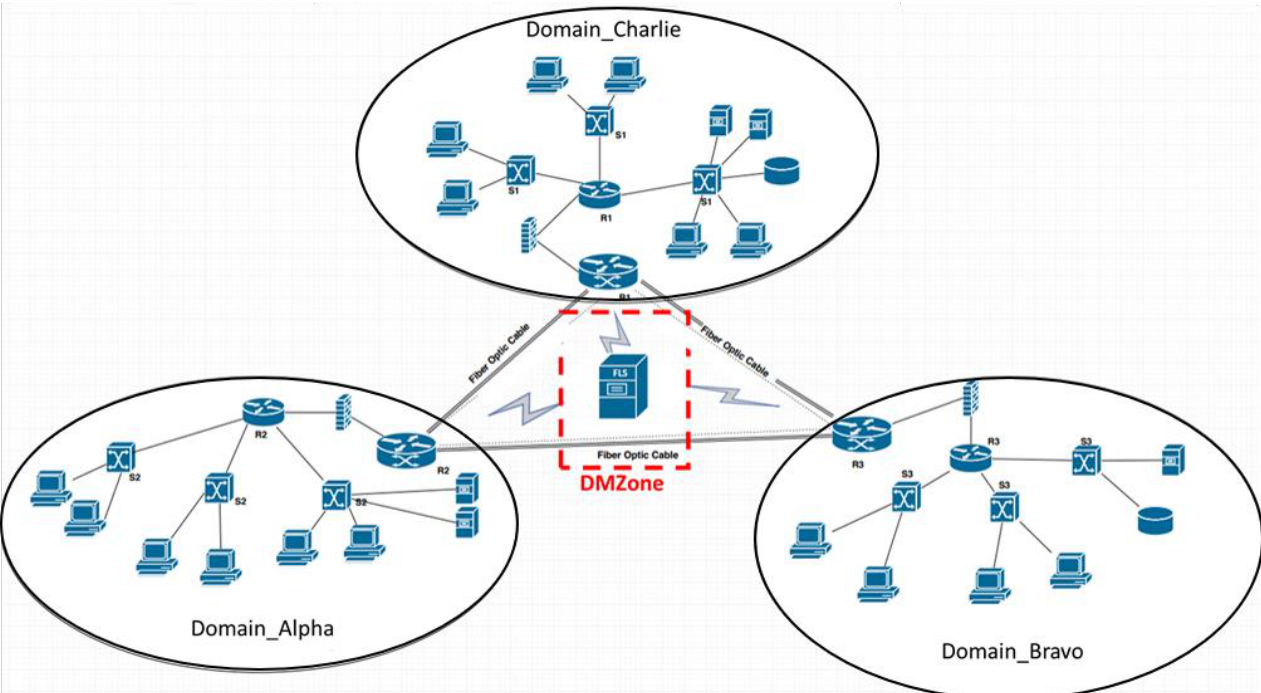
Figure 2. FAMEL architectural modelling.